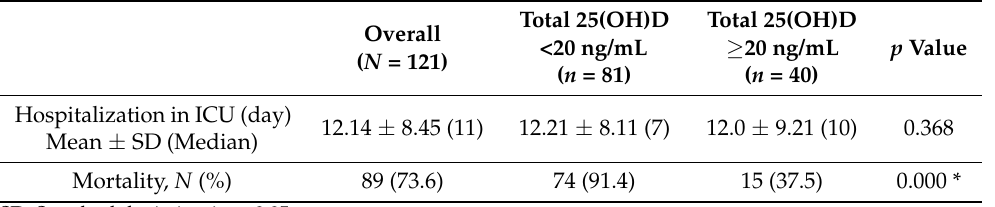
Table 7. Comparison of the prognosis of COVID-19 patients who had microbiological growth in cultures compared according to the vitamin D